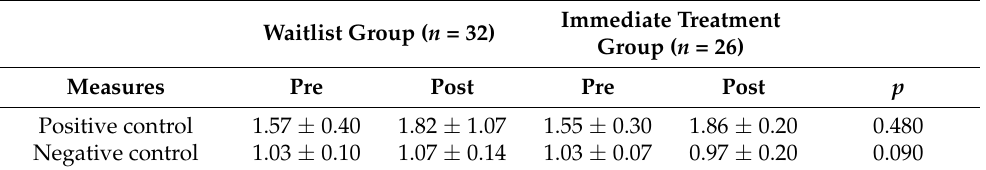
Table 3. Means for parenting behavior and between-group difference in